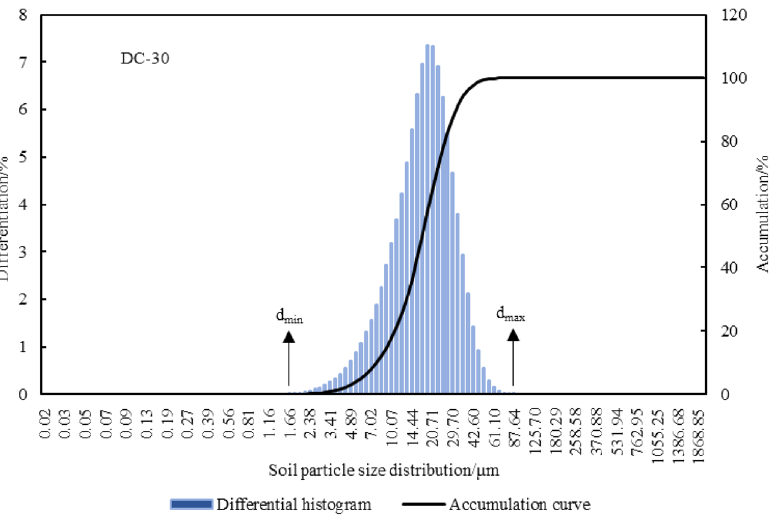
Figure 3. Volume content curve of soil PSD at DC sampling